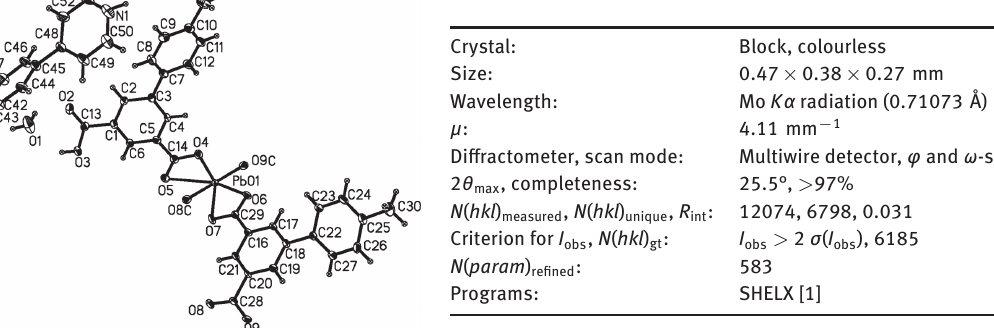
Table 1: Data collection and